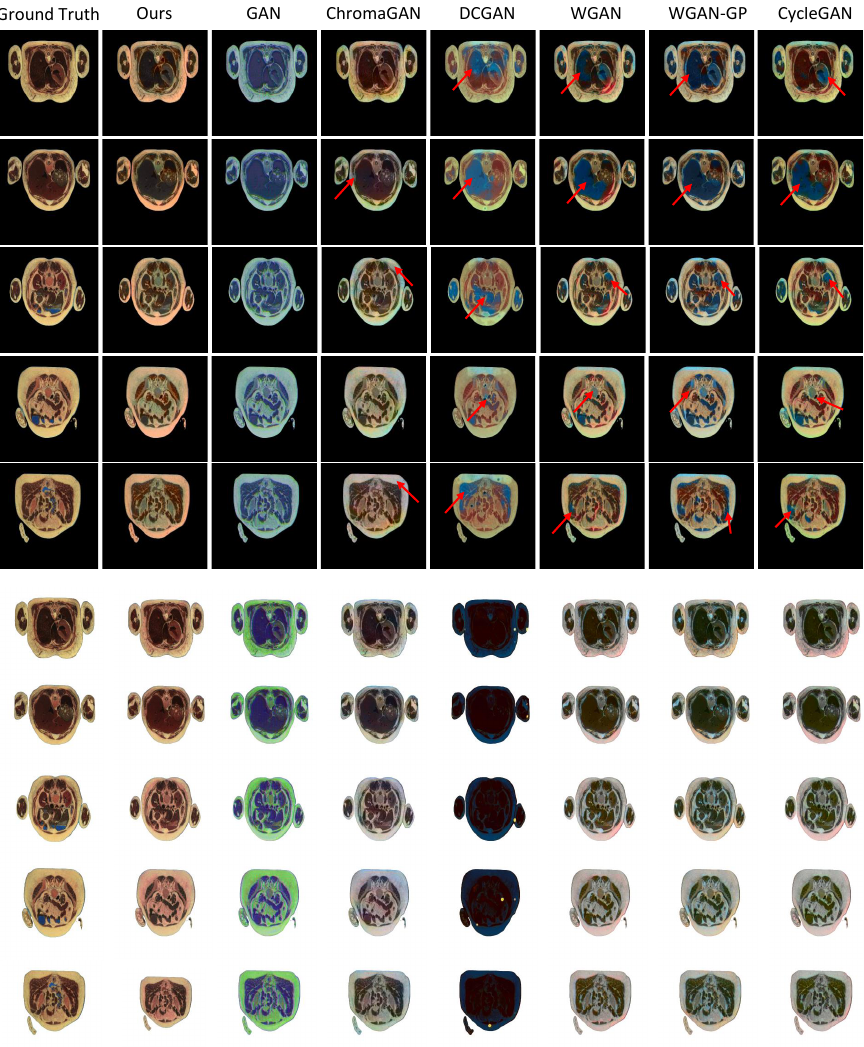
Figure 2. Qualitative colorization results over the cross-sectional cryosection images with black back- ground images and white background images, respectively. The first five rows show the colorization results using images with black backgrounds as input, while the last five rows are the colorization results using images with white backgrounds. The red arrow denotes the artifacts of the synthetic colorized